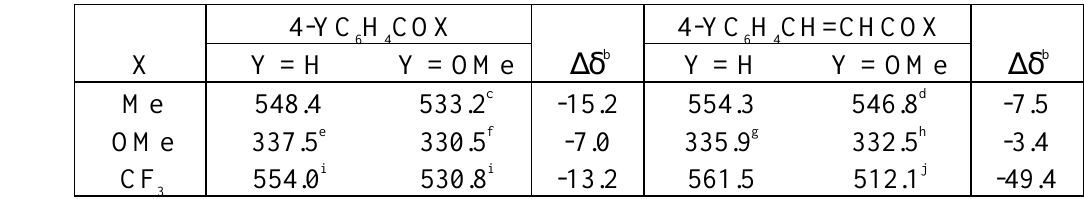
H COX and 4-YC 6 4